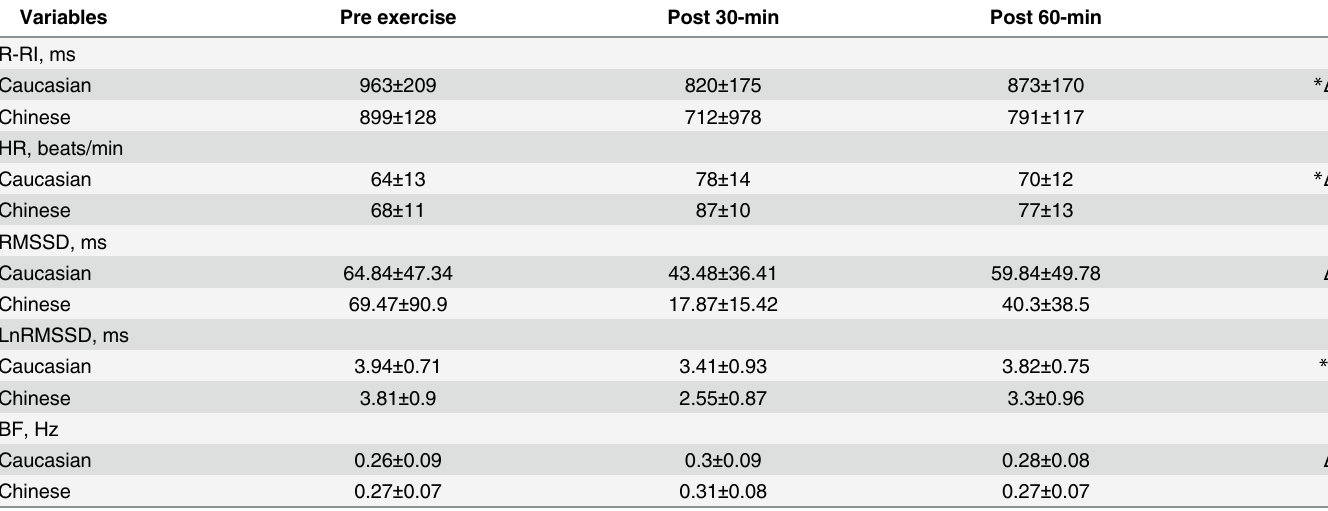
Table 3. Time domain measures of heart rate variability at baseline and recovery following exercise in Caucasian and